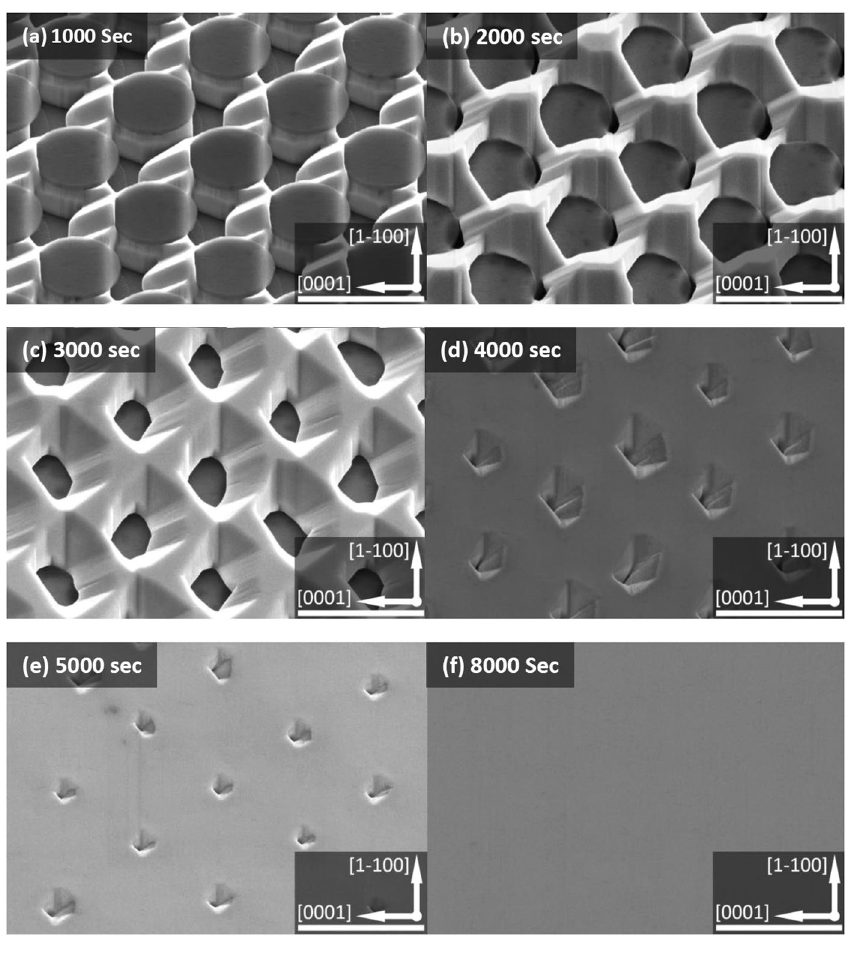
Figure 3. Plane-view SEM images of the nonpolar GaN overgrown on our regularly arrayed micro-rod array template as a function of growth time from 1000 to 8000 seconds. Scale bar: 4 μ m.